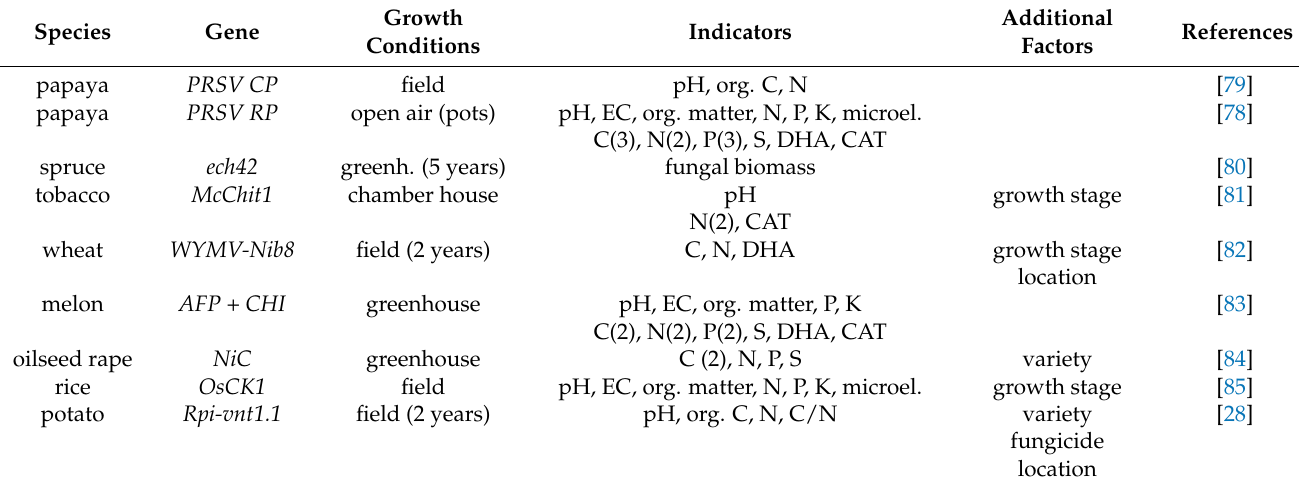
Table 3. Risk assessment of disease-tolerant transgenic plants on soil